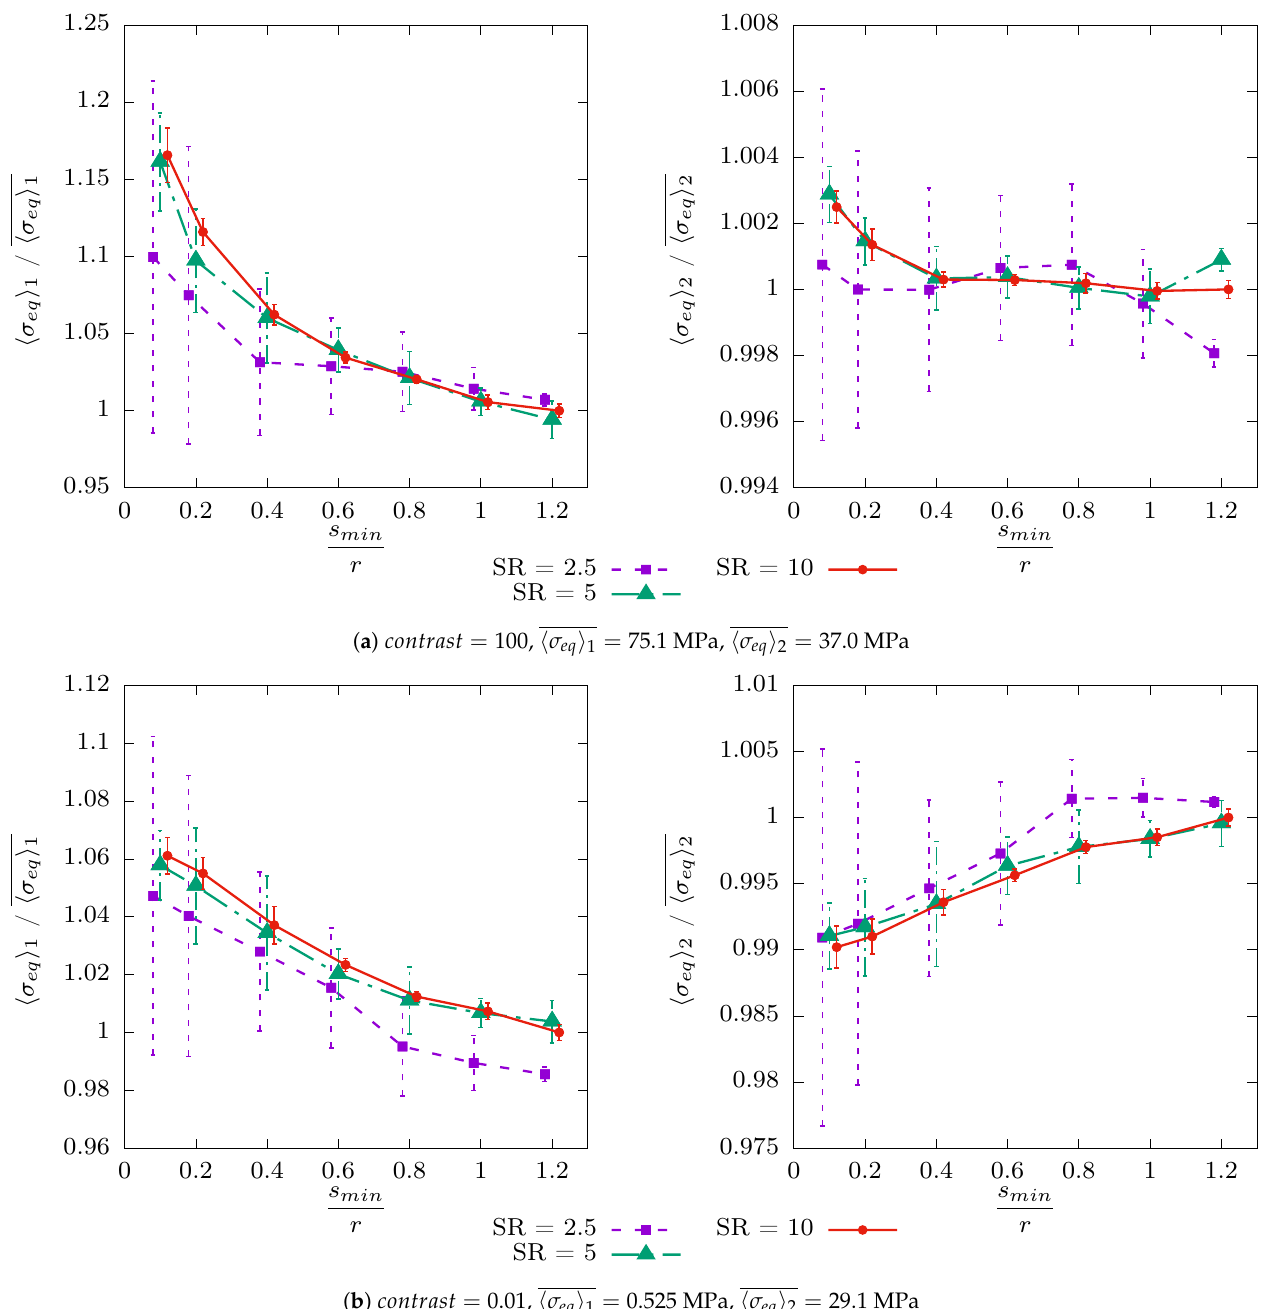
Figure 6. Mean values and standard deviations on the mean value for the first moment of equivalent stress by phase as a function of the packing parameter s min / r ( r = 10 µ m) for a volume fraction of inclusions f v = 13.4 %. For clarity, the error bars and dots are slightly shifted around for each studied minimum